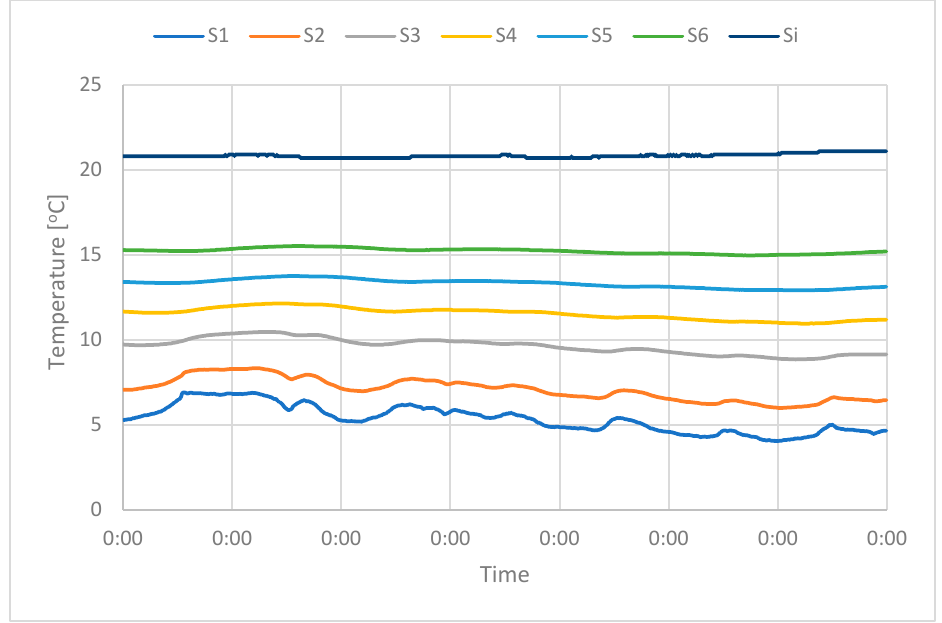
Figure 9. Recorded temperatures in the wall for winter week.